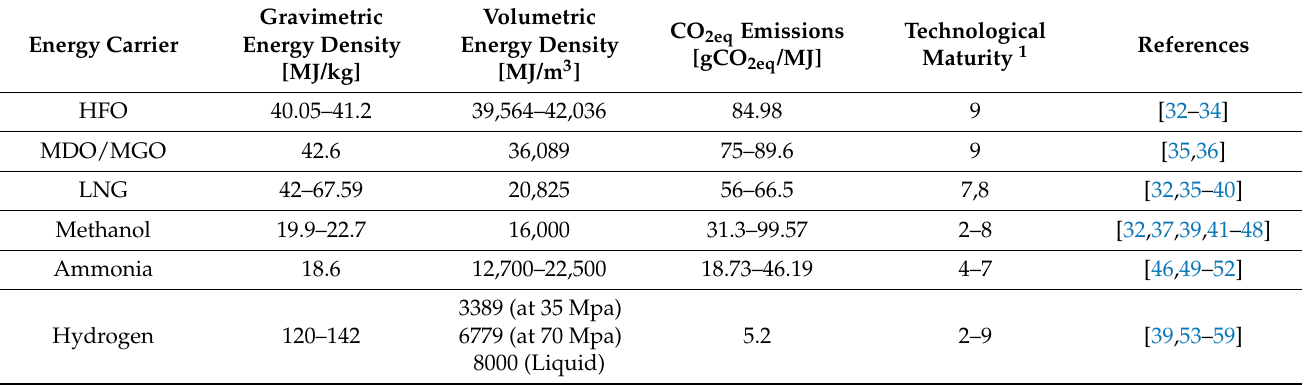
Table 1. Comparison of perspective energy carriers in marine transportation